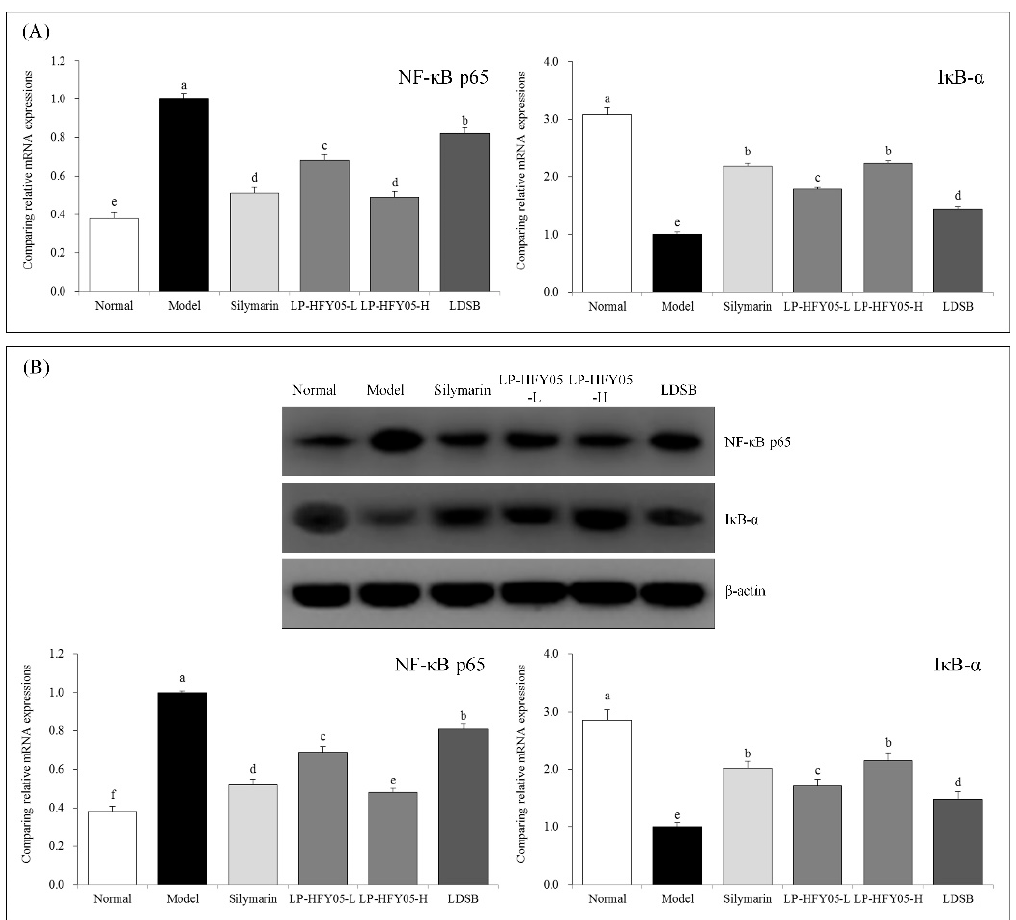
Figure 7. Nuclear factor (NF) κ B-p65 and inhibitor of kappa beta (I κ B)- α mRNA ( A ) and protein ( B ) expression in hepatic tissues of mice. Sample data in each group come from a normal distribution. The difference in variance between the two groups was significant ( p < 0.05). a–f Mean values with different letters in the bar are significantly different ( p < 0.05) according to Tukey’s honestly significantly different test. Silymarin: Mice treated with silymarin (100 mg/kg), LP-HFY05-L: Mice